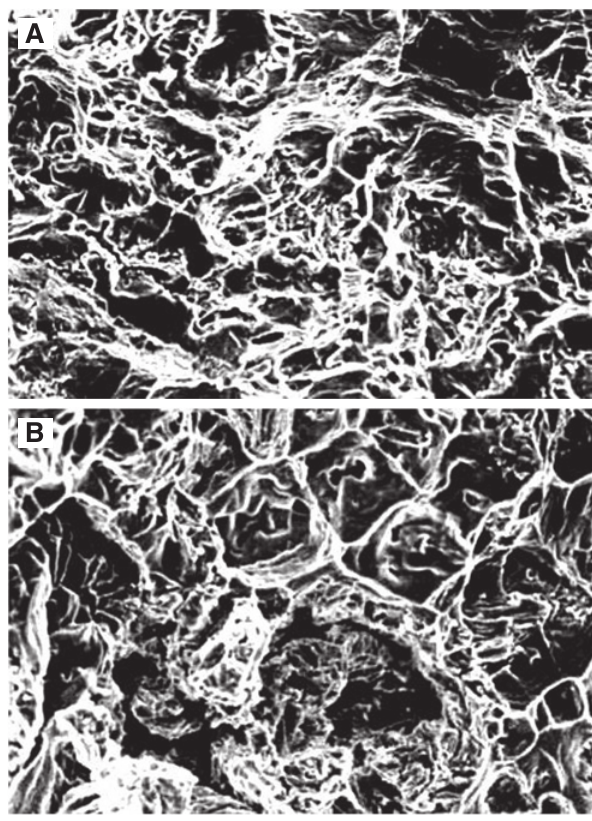
Figure 8: (A) scanning electron microscopy (SEM) showing the tensile fracture surface of composite with 5% addition; (B) SEM image of tensile fracture Al-7% V O added. 2 5